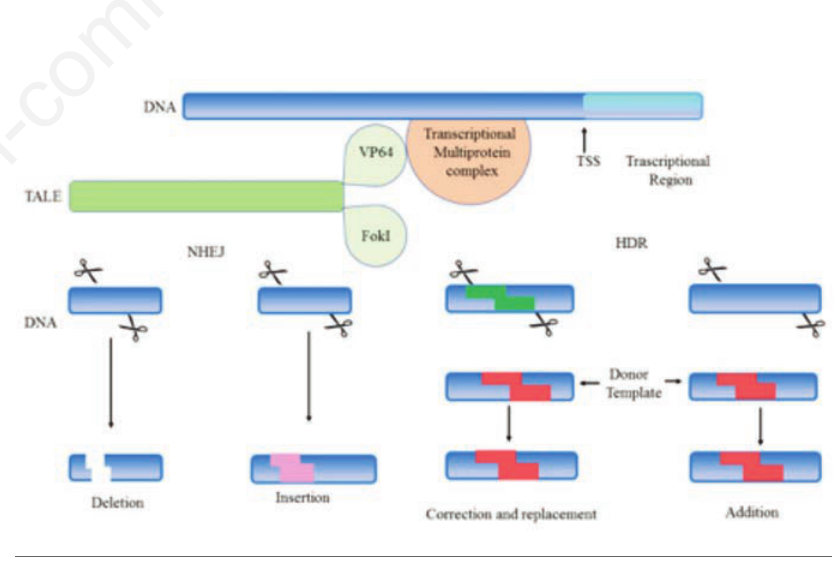
Figure 2. The TALE DNA-binding domain is fused to the synthetic VP64 transcriptional activator and assembles transcriptional multiprotein complexes with RNA polymerase II. TALE nucleases (TALENs)-induced DNA double-strand breaks (DSBs) typically result in one of two major DNA damage repair pathways: nonhomologous end joining (NHEJ) or homologous directed recombination (HDR) repair. NHEJ directly ligates the ends of the broken DNA strands and introduces an error-prone deletion or insertion at the repair site by DNA repair proteins and ligase. Gene editing through HDR from the donor template can result in gene additions and replacements.